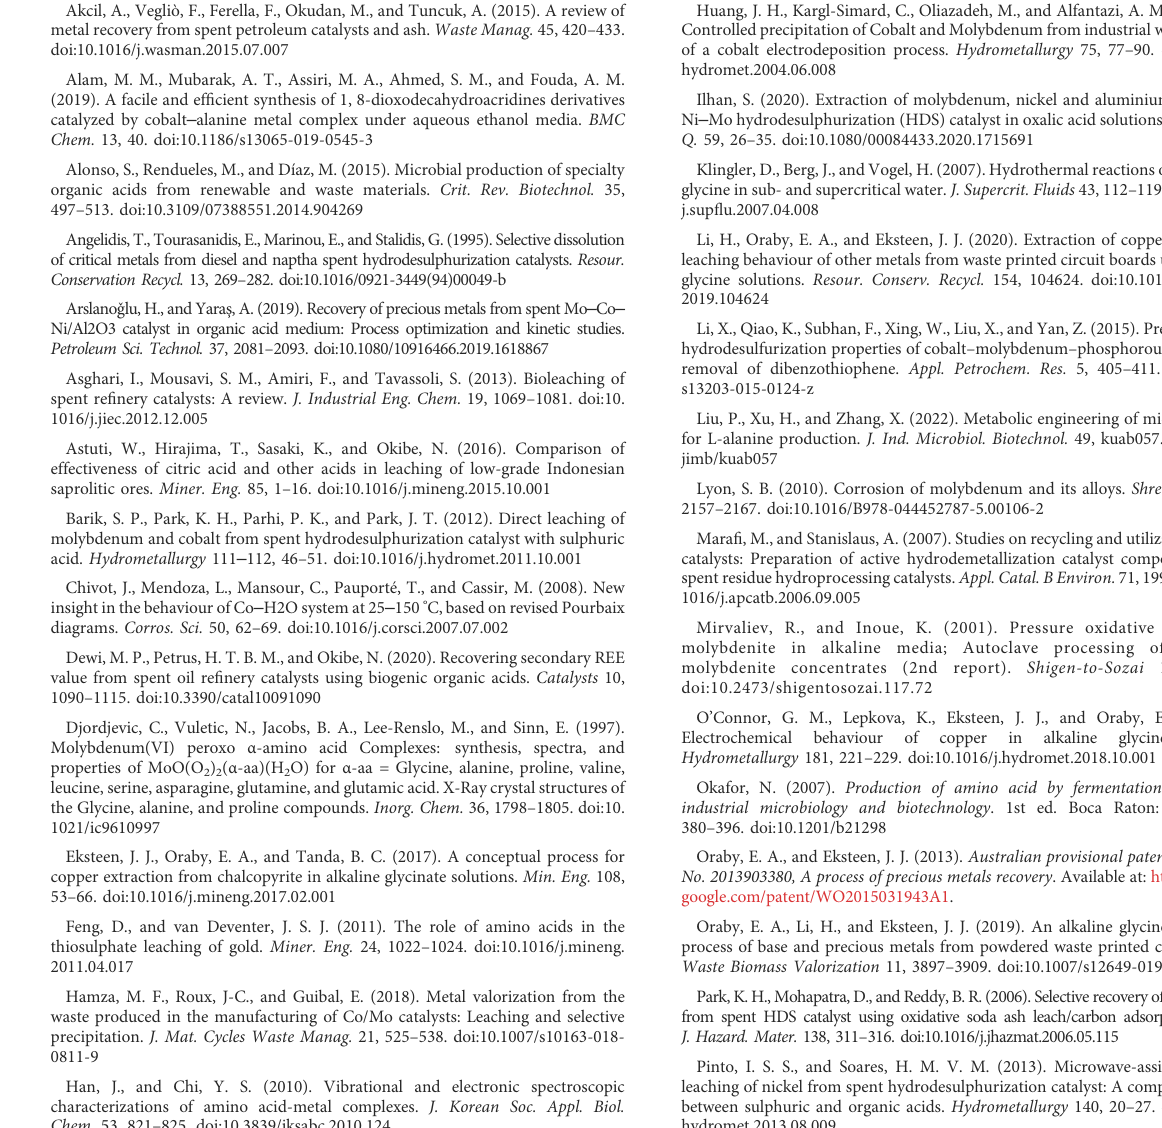
Pourbaix diagram for Aluminum — H 2 O system. (cid:1) Al = 3 × 10 − 6 M at 25 ° C (Pourbaix, 1974; Sukiman et al., 2012). SUPPLEMENTARY FIGURE S4 The effect of different temperatures (25, 45, and 70 ° C) on Step-1. SUPPLEMENTARY FIGURE S5 The effect of different temperatures (25, 45, and 70 ° C) on Step-2. SUPPLEMENTARY FIGURE S6 Sequential 3-step leaching of spent catalyst (Step-2 and Step-3 reversed fromFigure3).Step-1 (A-D) :AlkalineAlaleaching(pH ini 11)at45 ° C.Step- 2 (E – H) :SecondalkalineAlaleachingoftheStep-1solidresidueinfresh Ala solution (pH ini 11) at 45 ° C. Step-3 (I – L) : Hot water leaching of the Step-2 solid residue at 70 ° C. The dissolution pro fi le of Mo (A,E,I) ,